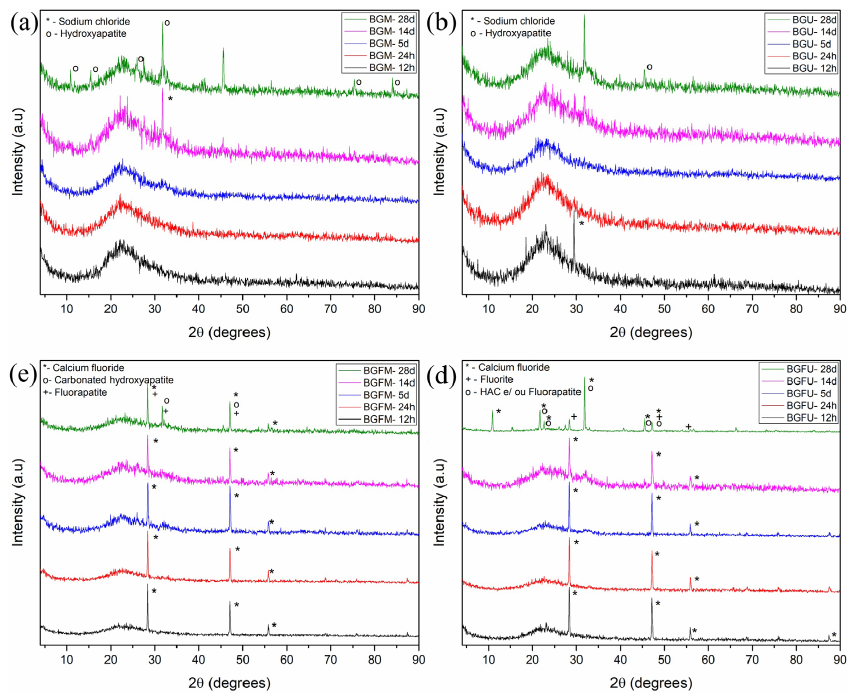
Figure 10. XRD patterns of the surfaces of the (a) BGM, (b) BGU, (c) BGFM and (d) BGFU after incubation in SBF for 12 h, 24 h, 5 d, 14 d and 28